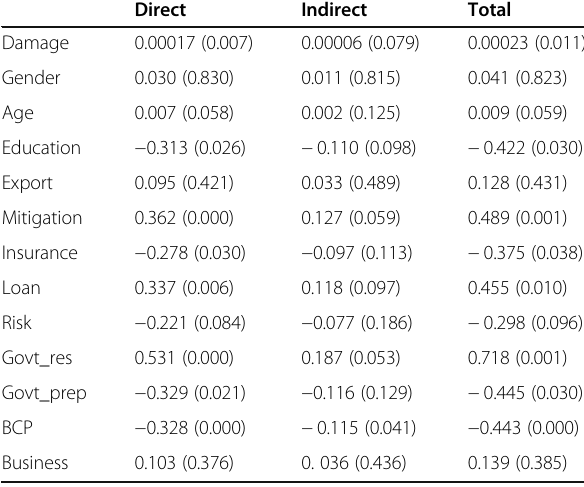
Table 4 Direct, indirect and total